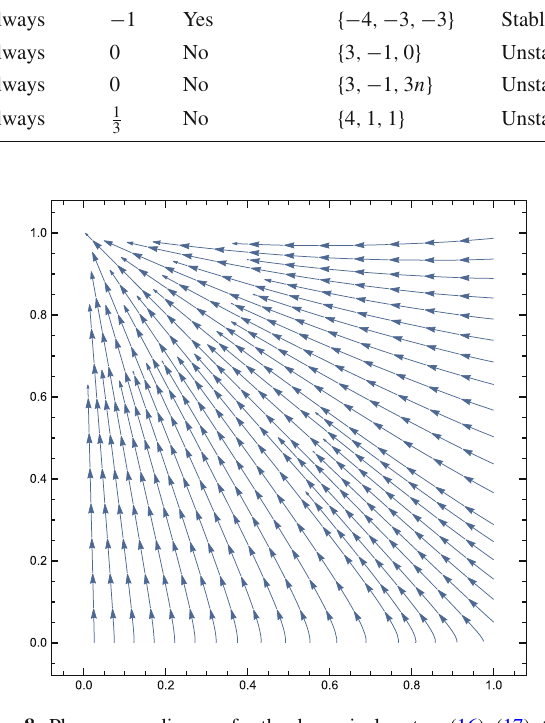
Fig. 8 Phase space diagram for the dynamical system (16), (17), (22) in the space of variables (cid:8) b ,(cid:8) (cid:2) for n < 1 and (cid:8) r = 10 − 4 . The unique attractor is the de Sitter point A Fig. 7 Phase space diagram for the dynamical system (16), (17), (22). We consider (a) (cid:8) b = 0 . 2996 ,(cid:8) r = 0 . 0004, (cid:8) (cid:2) = 0 . 7, (b) (cid:8) b = 0 ,(cid:8) r = 0 . 1, (cid:8) (cid:2) = 0 . 9 (c) (cid:8) b = 0 . 3, (cid:8) r = 0 . 2, (cid:8) (cid:2) = 0 . 5, (d) (cid:8) = 0, (cid:8) = 0 . 5, (cid:8) (cid:2) = 0 . 2, (e) (cid:8) = 0 . 7, (cid:8) = 0 . 1, (cid:8) (cid:2) = 0 . 2, for b r b r